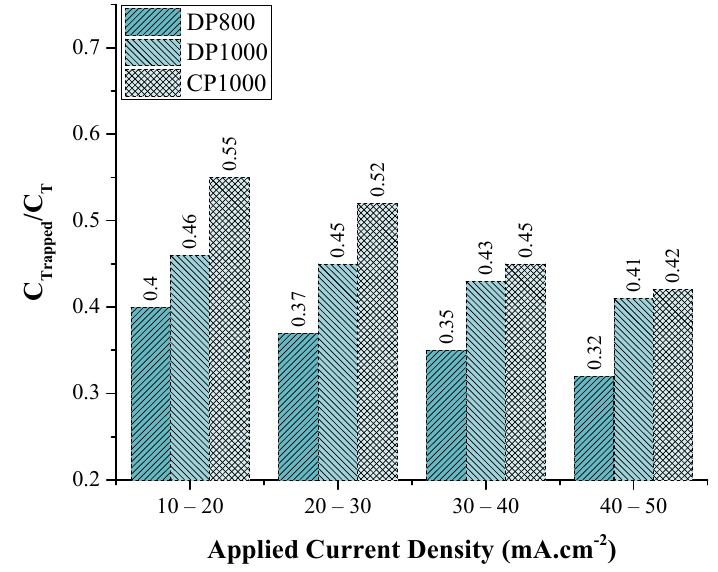
Figure 11. C Trapped /C T values as calculated from the partial permeation rise transient. Chun et al. [85] reported that the E a associated with dislocations and grain boundaries to be around 35 kJ · mol − 1 . Luppo et al. [86], in their study of low carbon martensitic steel, found that E a for lath interfaces to be 46 kJ · mol − 1 . Wong et al. [87] found the energy required to release hydrogen from dislocations to be around 21 kJ · mol − 1 . Based on these previous results, the hydrogen released from the reversible traps may be present in the grain boundaries, dislocations, and martensite lath interfaces in DP and CP steels along with cementite particles present in CP steels. The low hydrogen uptake, the lower trap density, and the presence of stronger traps in CP steels are expected to render this steel more resistant to HE as compared to the DP steels [16,37,63,76,88–90]. Figure 9 suggests that C L is higher for DP1000 at low charging current density, but at higher charging current density, C L is higher for DP800 (Figure 9b). Both DP steels have ferrite and martensite, with higher martensite fraction in DP1000. Martensite, due to its high dislocation density, acts as a hydrogen trap, and resultantly DP1000 has higher trap density than DP800. Thus, the traps in DP800 are quickly get saturated compared to the traps in DP1000, leading to enrichment of hydrogen in DP800 lattice. This observation is particularly interesting in terms of embrittlement phenomenon as Koyama et al. [91] ob- served that the crack initiation in DP steels occurred through martensite cracking and propagated through the ferrite/martensite interface. The martensite or the martensite/fer- rite interface thus can act as strong or weak H trapping sites depending on the activation energy. Another interesting observation is made by comparing H concentration change at the charging side and discharging side during each fall transient. The change in the hydrogen concentration at the discharge side ( C T * ) is calculated by measuring the area of the exper- imental curve. It is observed that for all the steels, the concentration of hydrogen coming out of the discharge side is almost a third of the change in the concentration of the charg- ing side. The ratio between the change in the hydrogen concentration at the discharging side and at the charging side is 0.36 for DP800, 0.33 for DP1000, and 0.30 for CP1000 steels (Table 3). This helps to get an insight into the possible hydrogen distribution within the metal. Hadam et al. [64] suggested that H distribution within the material is uneven along the material cross-section, with most of the H trapped at the sub-surface on the charging